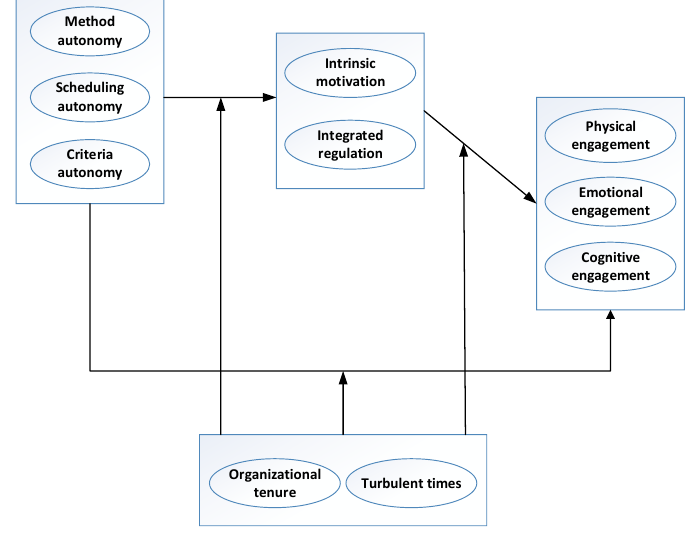
Figure 1: The conceptual